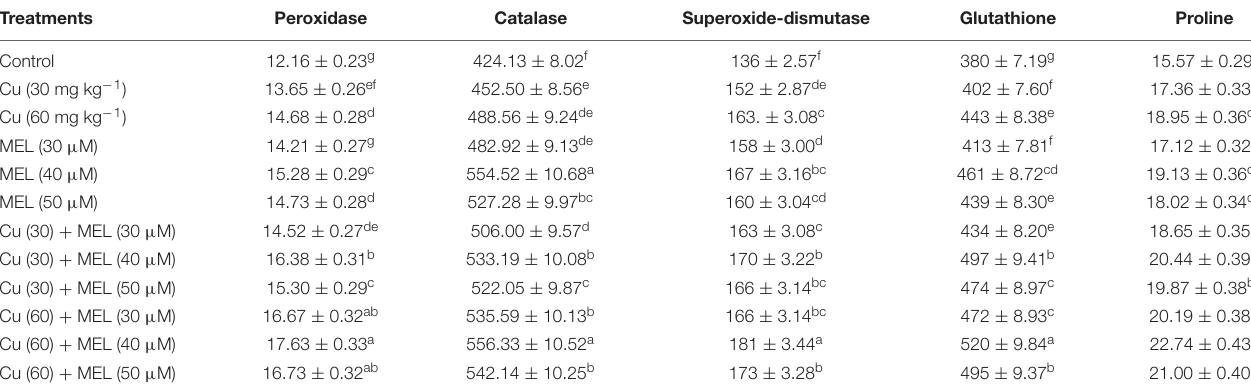
TABLE 6 | Effect of different levels of soil applied Cu (0, 30, or 60 mg kg − 1 ) and/or MEL (30, 40, or 50 µ M) on leaf peroxidase (units g − 1 FM), catalase (mM H 2 O 2 decomposed g − 1 FM), superoxide dismutase (unit g − 1 FM), glutathione (nmol g − 1 FW), and proline (mg g − 1 FM) content of Brassica juncea at 45 DAS. Treatments